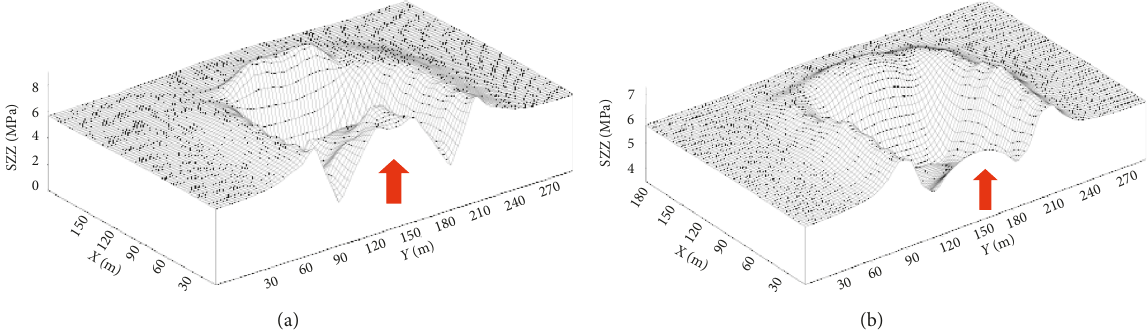
Figure 10: Stress perspective for a 120m mining advance: (a) caving and (b)